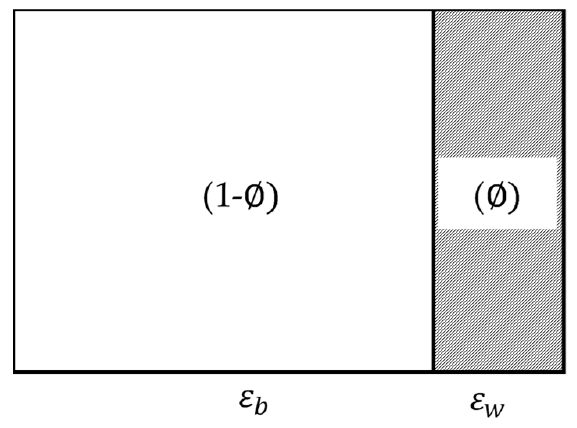
Figure 1. Schematic showing heterogeneity of 𝜀 in a mixing vessel.